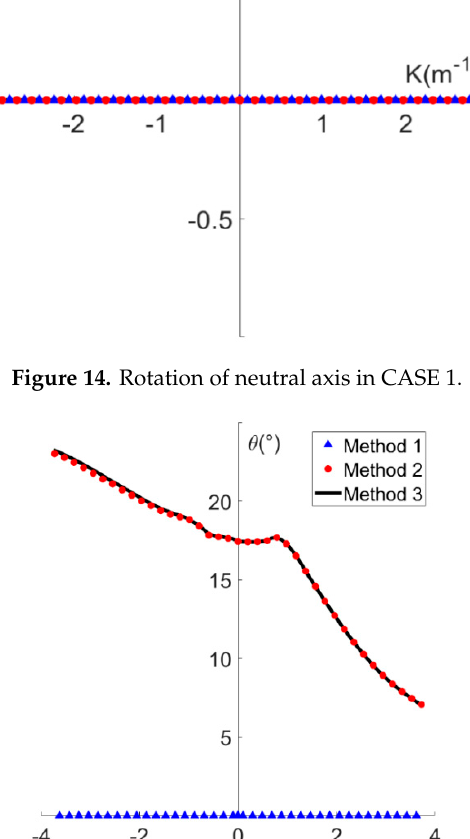
Figure 15. Rotation of neutral axis in CASE 2.